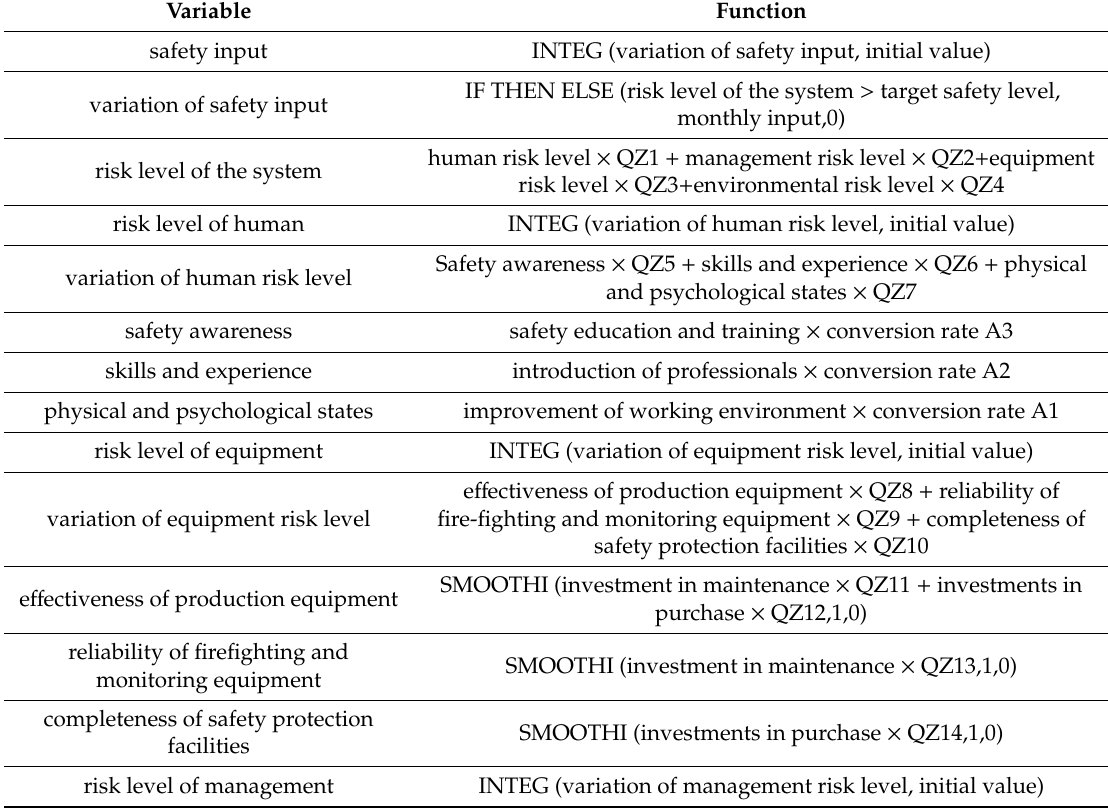
Table 1. Main variables and